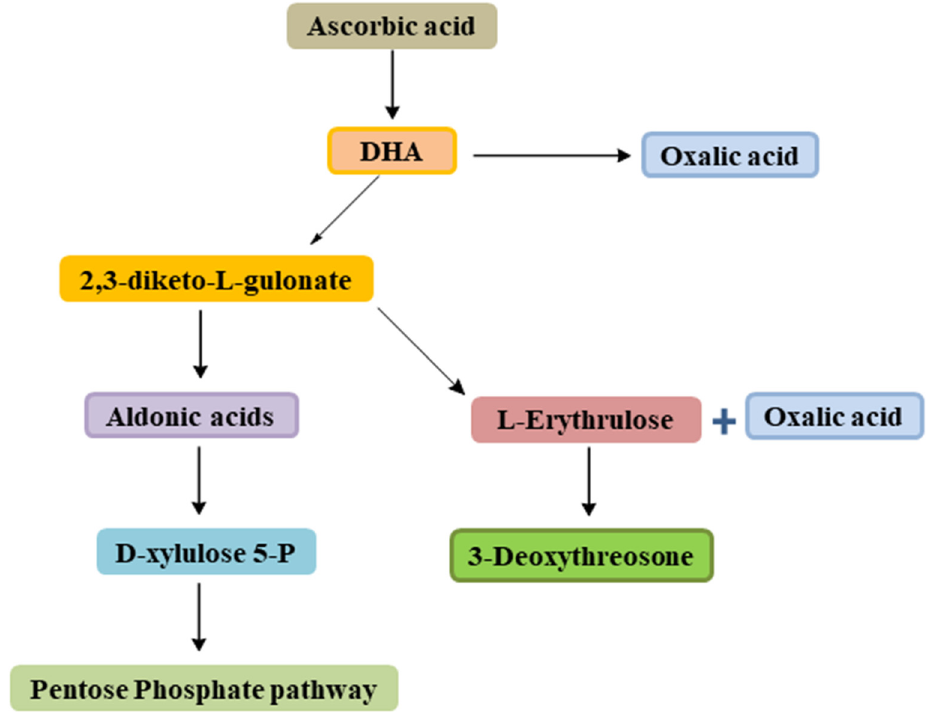
Figure 3. Degradation of ascorbic acid into various products during metabolism.